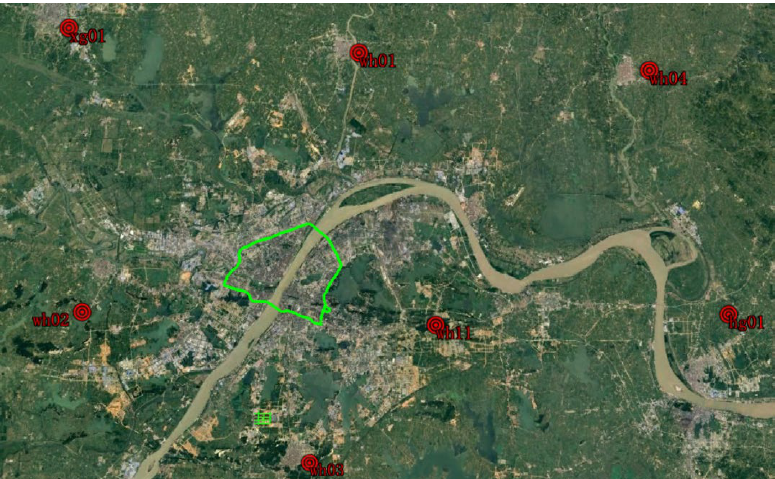
Figure 6. Distribution of seven reference stations for generating the atmospheric and UPD products. The green lines denote the trajectories of the two experiments. Table 2. GNSS data processing strategy of PPP and PPP-RTK.